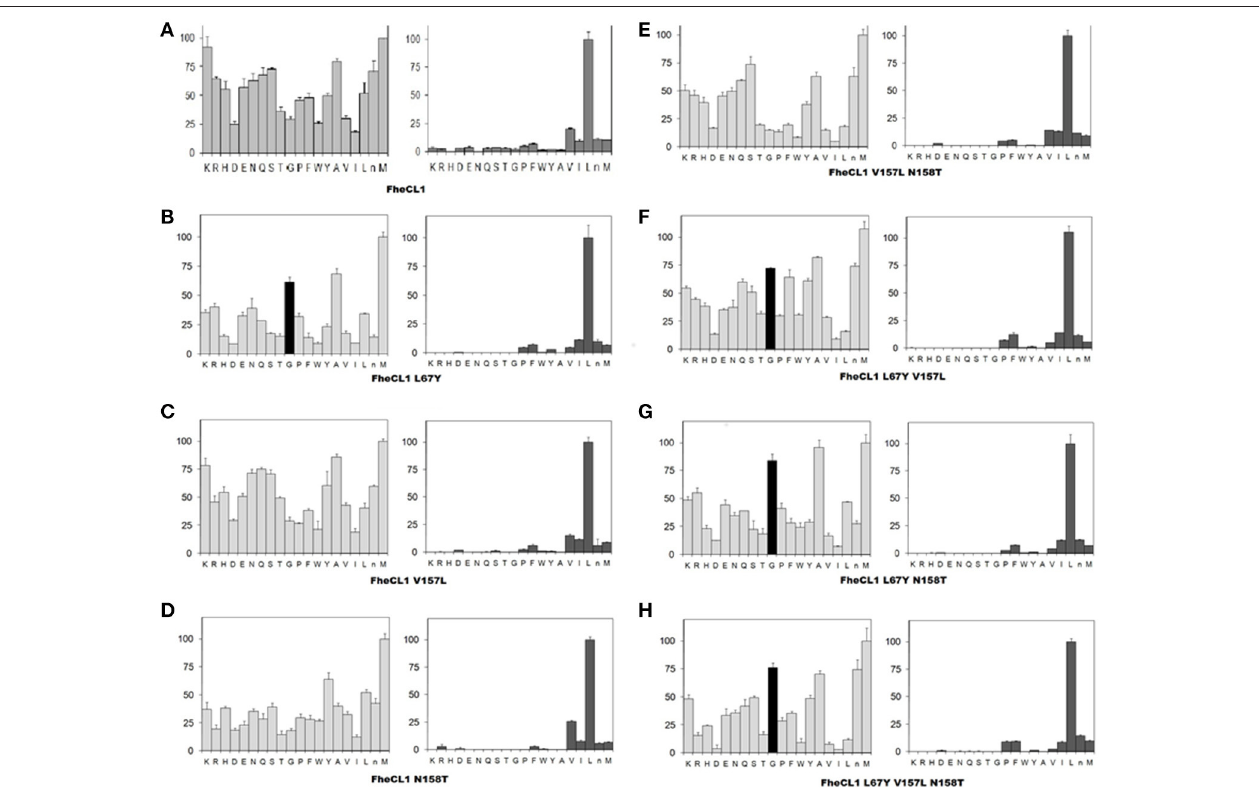
FIGURE 3 | Profiling of the P 2 and P 3 substrate specificity of Fh CL1 enzyme variants using PS-SCL (A–H) . The y axis shows the enzymatic activity, against each of the 20 sub-libraries with P 2 and P 3 position of the substrates fixed, as a percentage relative to the highest activity in each library (the hydrolysis rates for the Leu- and Met- fixed peptide pools at P 2 and P 3 , respectively, are taken as 100%). The x axis shows the different fixed amino acids using the one-letter code ( n = norleucine). The error bars display the standard deviation from triplicate